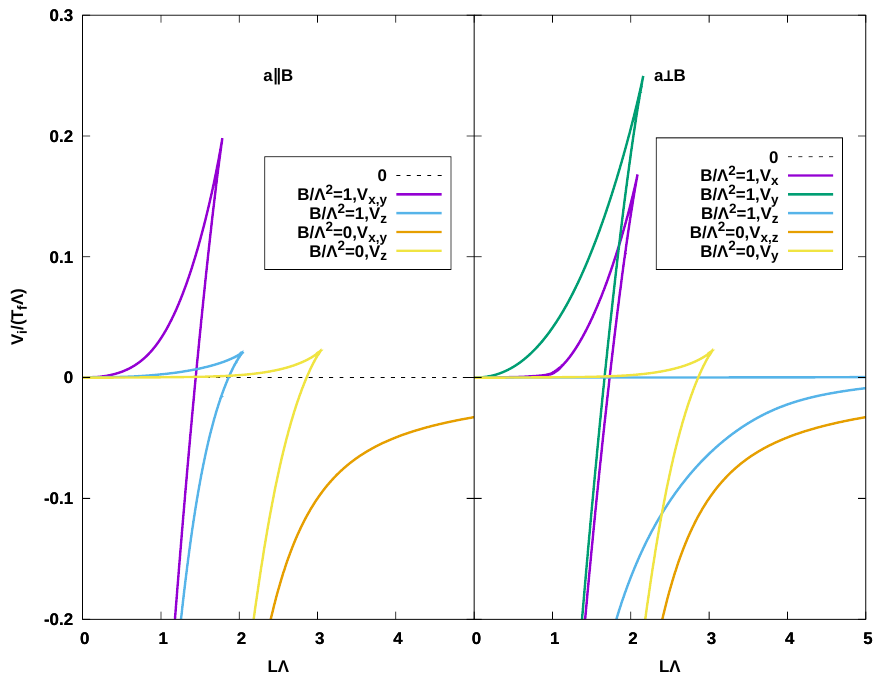
Figure 5 . Quark-antiquark potential in the presence of anisotropy and magnetic field, for a = 1 and B = 1 (in units of Λ ∼ 1 GeV) and c = 0 . 25 . The magnetic field B is aligned along the z -direction while the anisotropic deformation is introduced along the z - or y -direction (parallel and perpendicular configurations, respectively). In general, the combined effects of a and B push the transition to shorter distances, while increasing the tensions. However, two cases do not follow this pattern: V in the case where a and B are perpendicular/parallel to each other. In these situations z the effects of a and B are completely constructive/destructive in the IR and as a result, the main effects are enhanced. This is described more in detail in the main